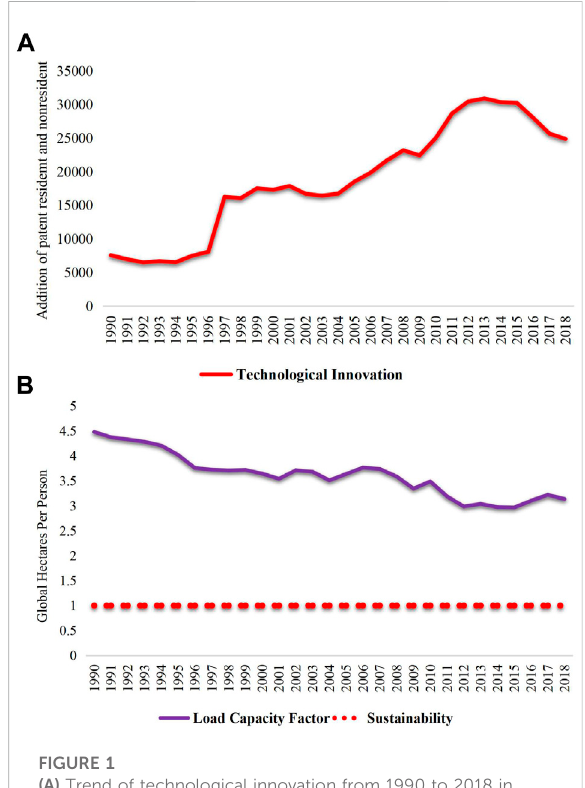
FIGURE 1 (A) Trend of technological innovation from 1990 to 2018